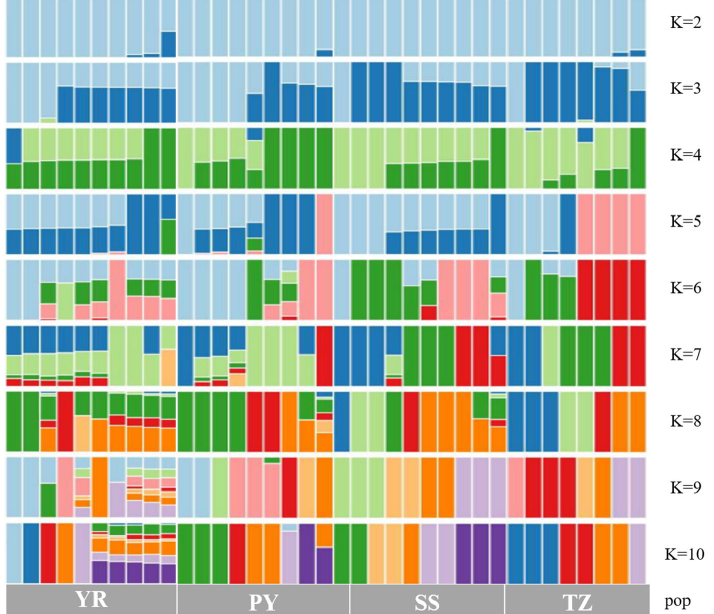
Figure 3. Population structure of Coilia nasus by SNPS Analysis (K = 2–10). Note: Each column in the picture represents an individual, and the length of different color fragments represents the proportion of an ancestor in the individual’s genome.